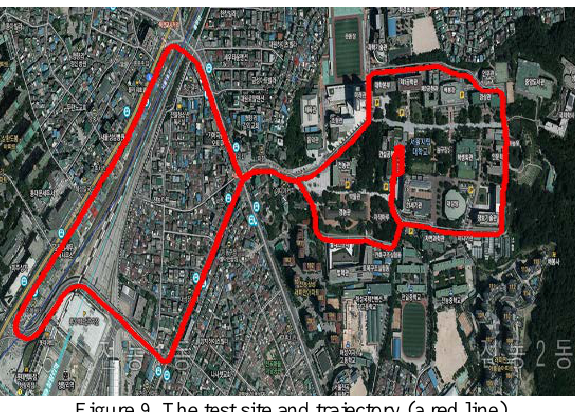
Figure 9. The test site and trajectory (a red line)